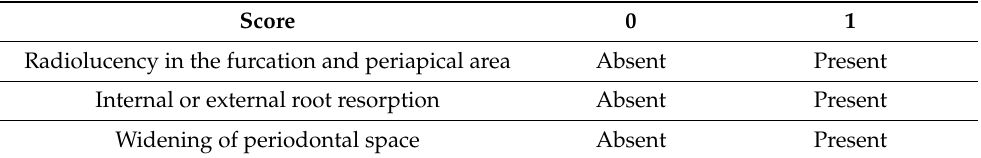
Present Table 3. Scoring criteria for the parameters for radiographic evaluation of pulpotomised molars. Score 0 1 Absent Present Absent